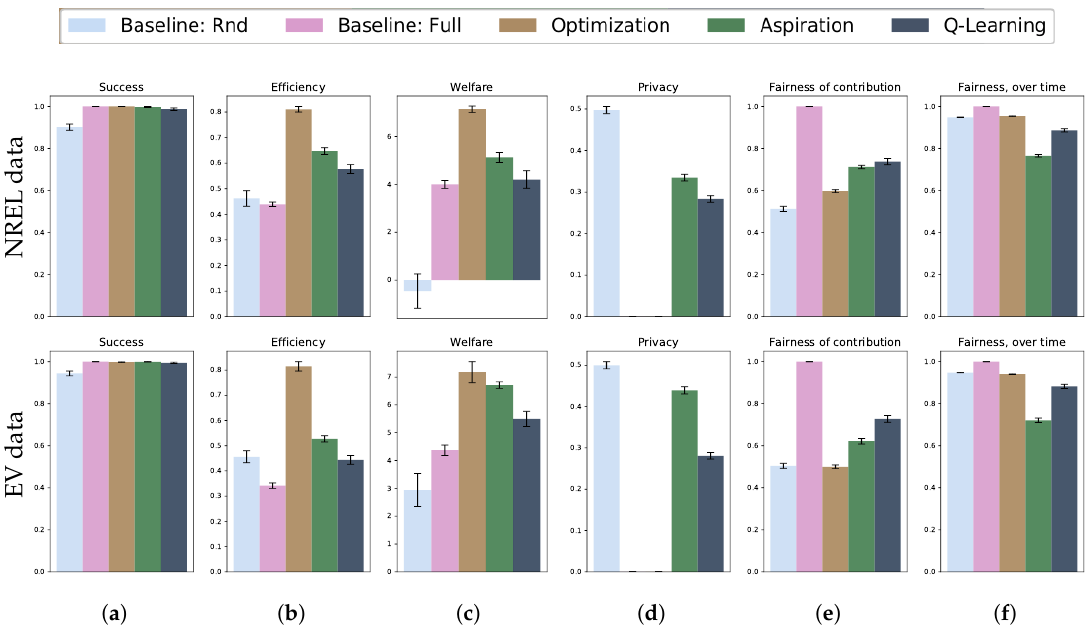
Figure 3. Comparison of contribution strategies. The plots show trade-offs between centralized optimization, aspiration learning and Q-Learning in terms of success rate ( a ), efficiency ( b ), social welfare ( c ), privacy ( d ) and fairness ( e , f ). Optimization offers the highest success rate and efficiency, while aspiration learning and Q-Learning offer higher privacy. Q-Learning offers higher fairness than aspiration learning on both